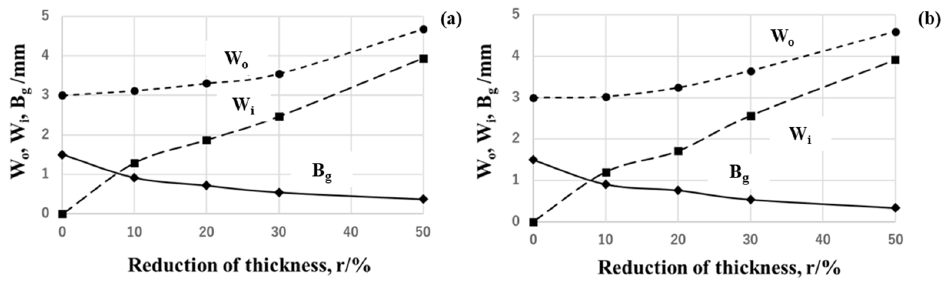
Figure 5. Variation of the wire width (Wo), the contact interface width (Wi) and the bulging dis- placement (Bg) with the increasing reduction in thickness. ( a ) Forged pure titanium wire by using the Ns-SKD11 punch, and ( b ) forged pure titanium wire by using the Cs-SKD11 punch. In the present CNC stamping, the stroke was measured by the linear-scale gage, and the applied load was also monitored by the load cell, which was embedded into the lower cassette die. Both the Cs-SKD11 punch and the β-SiC-coated SiC die were utilized for up- setting to describe the plastic flow behavior of pure titanium and β-titanium wires with increasing r. Figure 6a depicts each load–stroke relationship of forged pure titanium wires for upsetting down to r = 10%, 20%, 30%, 40%, and 50%, respectively. These five load– stroke relations were edited into a single master relationship between the applied load (P) to pure titanium wire and the stroke (δ) in upsetting. In this master curve, the applied load monotonously increases with the stroke since the pure titanium work flattens with r and its width broadens with the stroke, as observed in Figure 5b. As analyzed in Figure 6b, when forging the β-titanium wires with increasing r, both P and δ reduced more than those P and d at each r in Figure 6a. This reveals that β-titanium plastically deforms more homogeneously during upsetting, to provide the P and δ lower than those in the pure titanium. This comparison of P–δ relations between two works suggests that inner plastic straining behavior must be different between two works even when using the same punch and die pair.